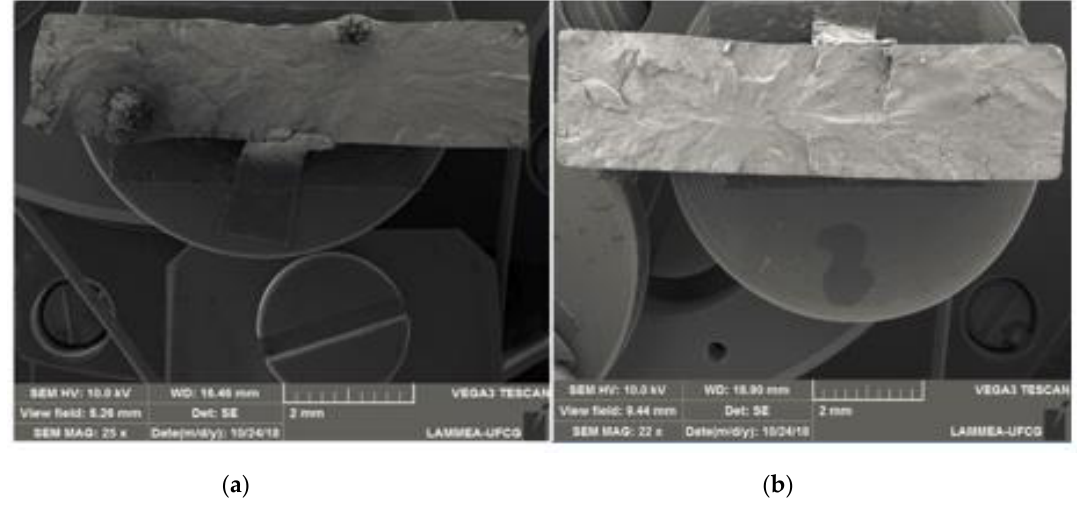
Figure 9. SEM images of PET/ZnO 1% ( a ) and PET/ZnO 1%-NaOH ( b ).